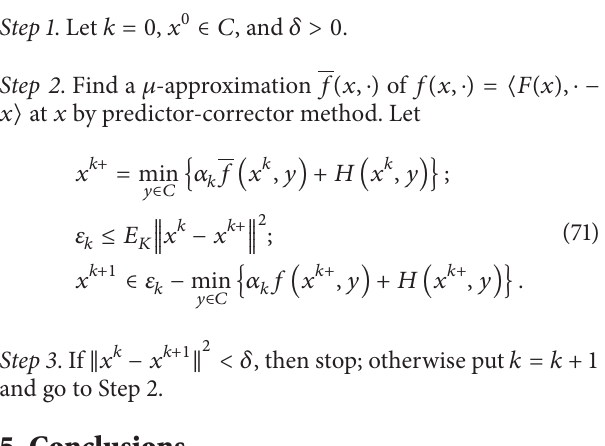
Algorithm 30 (the predictor-corrector algorithms for ( VIP )